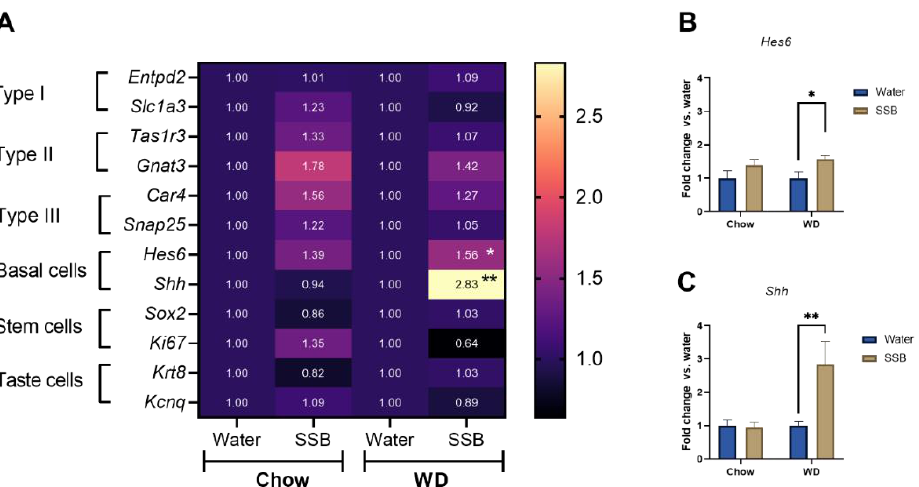
Figure 3. ( A ) Representative image for the analysis of the fungiform papillae after staining with methylene blue taken at 10 × magnification. The light-stained fungiform papillae with the darker taste pore in the middle, exemplarily marked with arrows, can be easily distinguished from the non-gustatory filiform papillae (dark blue stained). ( B ) Mean number ± SEM of fungiform papillae at the anterior part in front of the intermolar eminence, and ( C ) mean chemosensory surface ± SEM from the fungiform papillae, calculated from the size and number of the fungiform papillae from mice receiving either a standard diet (chow) or Western-type diet (WD) with water (Water, blue bars) or a sugar-sweetened beverage (SSB, brown bars) as a drink for 24 weeks. Statistical significance was tested using two-way ANOVA with the Holm–Sidak post hoc test from n = 11–12 for the chow group, and n = 7–8 for the WD group, assumed at p < 0.05 and is marked by *.